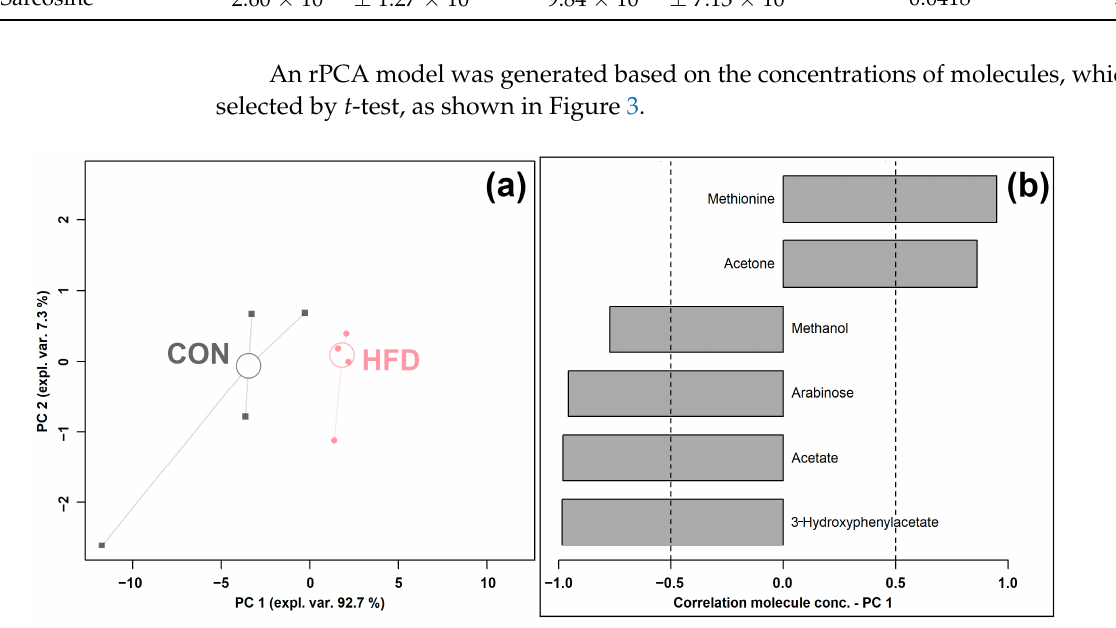
Figure 3. rPCA model was performed on the basis of molecules whose concentrations showed significant differences between CON and HFD groups. Scoreplot ( a ) shows the overall structure of the data, and the loading plot ( b ) shows the significant relationships between the concentration of each molecule and its importance over PC 1.